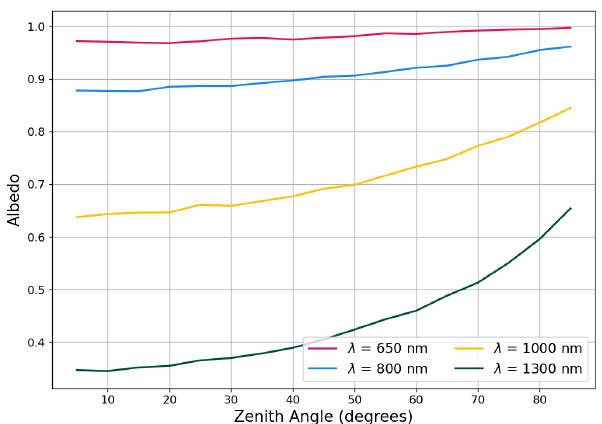
Figure 9. Simulated spectral albedo as a function of the incident zenith angle for selected wavelengths. Note these simulations were run with 25000 photons for a snow depth of